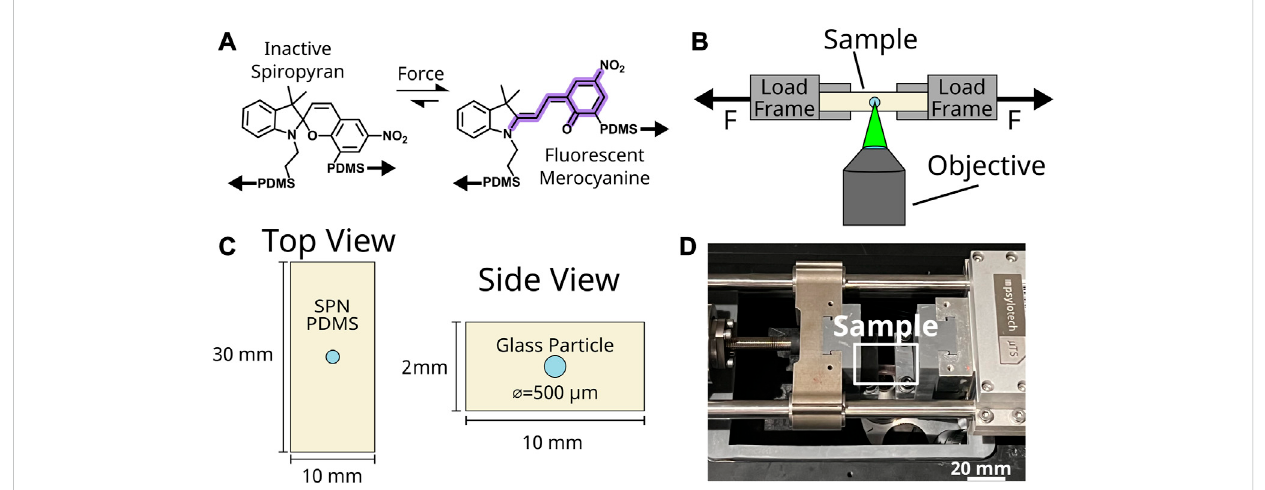
Mechanophorecalibrationexperimentalapproach. (A) Spiropyran(SPN)mechanophores(MPs)transitionfromanon- fl uorescent,inactive statetoa fl uorescently active state through an isomerization induced by the application of force. (B) MP activation was observed in situ by mounting a load frame above a laser scanning confocal microscope. Samples were deformed under uniaxial tension while both the force-displacement and fl uorescence images were obtained. (C) Uniaxial tension specimens were fabricated by casting a polydimethylsiloxane (PDMS) network functionalized with SPN into sheets containing a single spherical silica particle embedded at the midplane. Dimensions of the specimen are detailed in the schematics of the top and side view of a sample. (D) Image of in situ uniaxial testing setup comprised of a micromechanical load frame mounted over the inverted microscope